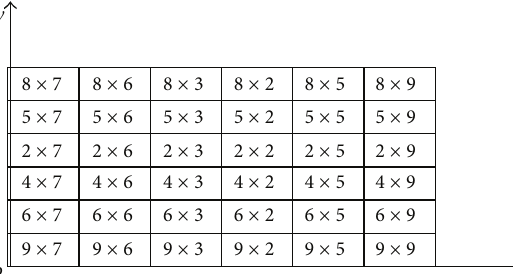
Figure 2: Antenna with 1088 elements on rectangular grid config- ured into 36